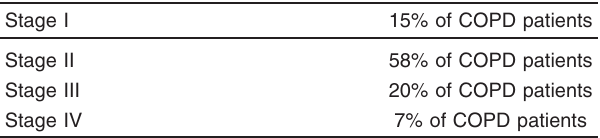
Table 3 The distribution of chronic obstructive pulmonary disease patients according to the Global Initiative for Chronic Obstructive Lung Disease stages